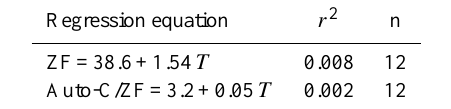
Fig. 3. Relationships between temperature and respiration (C R ) , ammonia excretion (N E ) and phosphate (P E ) excretion rates.